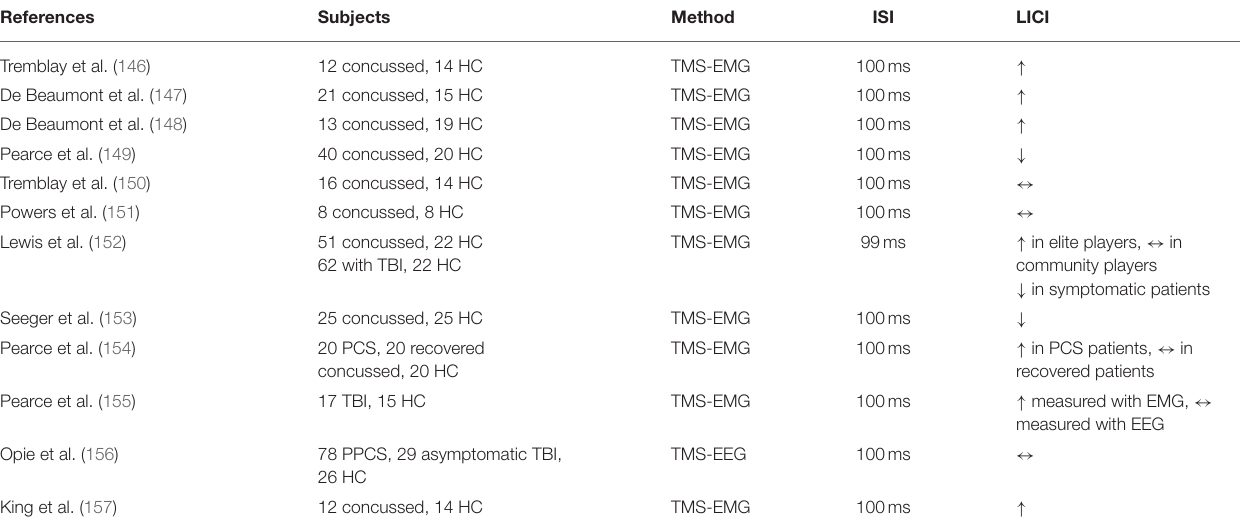
TABLE 13 | LICI in patients with traumatic brain injury.